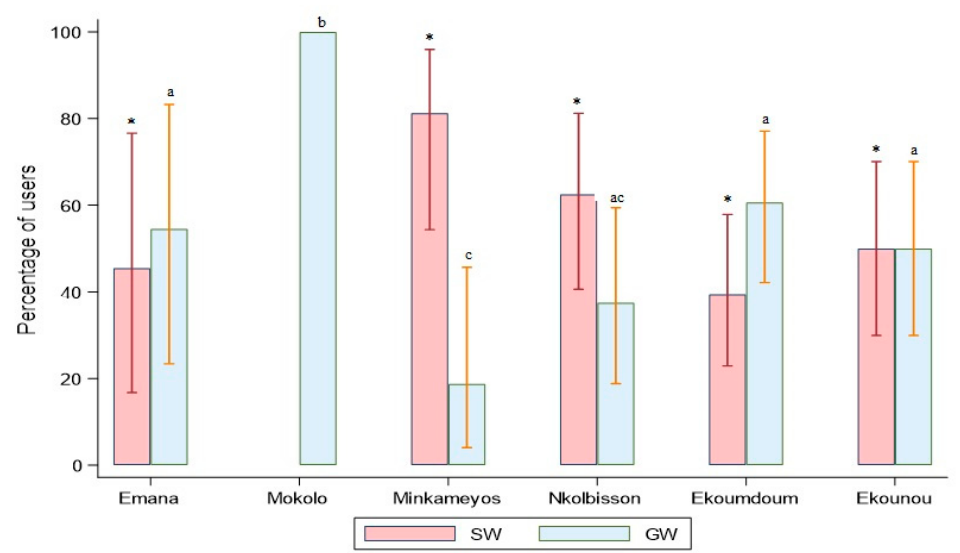
Figure 2. Percentages and types of irrigation water used in the studied areas (SW: surface water; GW: groundwater; same letters for the respective irrigation water type are not significantly different at p < 0.05; * not significantly different at 95% exact confidence intervals).